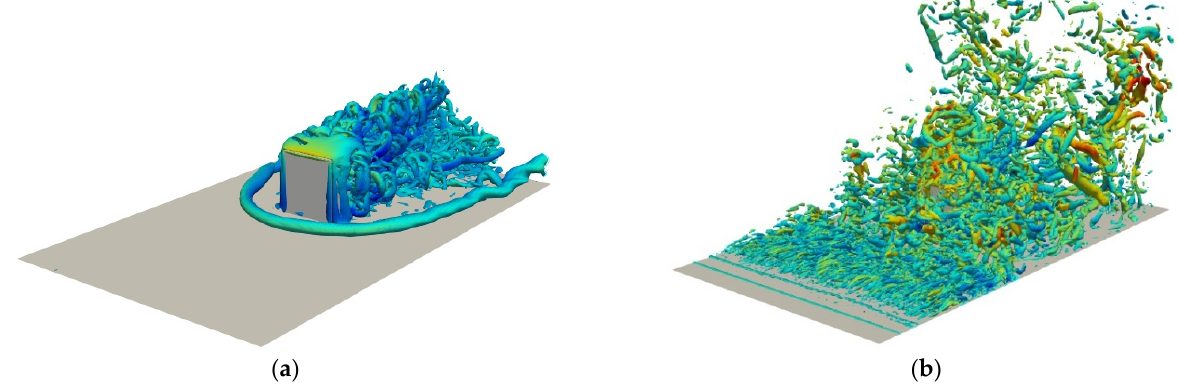
Figure 5. Instantaneous isosurfaces of the Q-criterion (t = 20 s) coloured by 𝑈 (cid:3053) velocity component. ( a ) In the absence of fire, and ( b ) in the presence of fire.